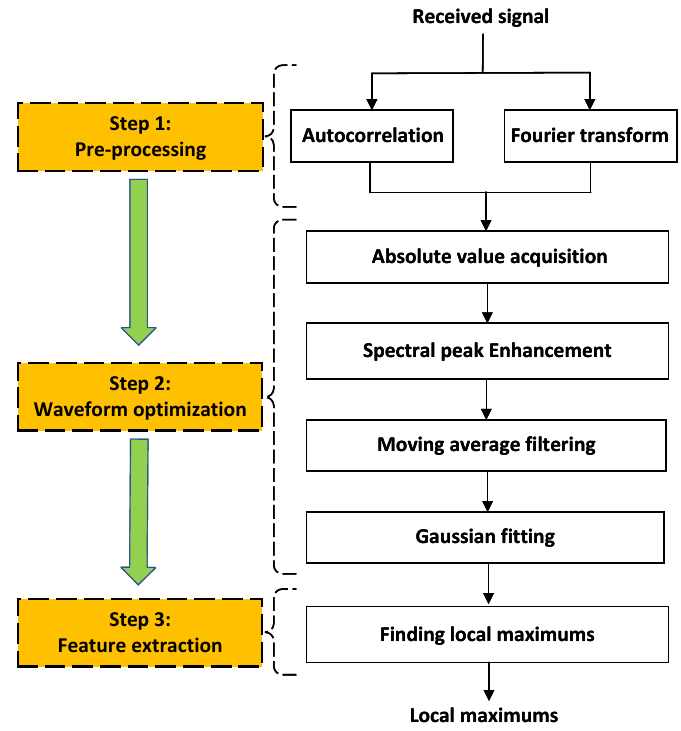
Figure 2. The process of the spectral peak feature extraction